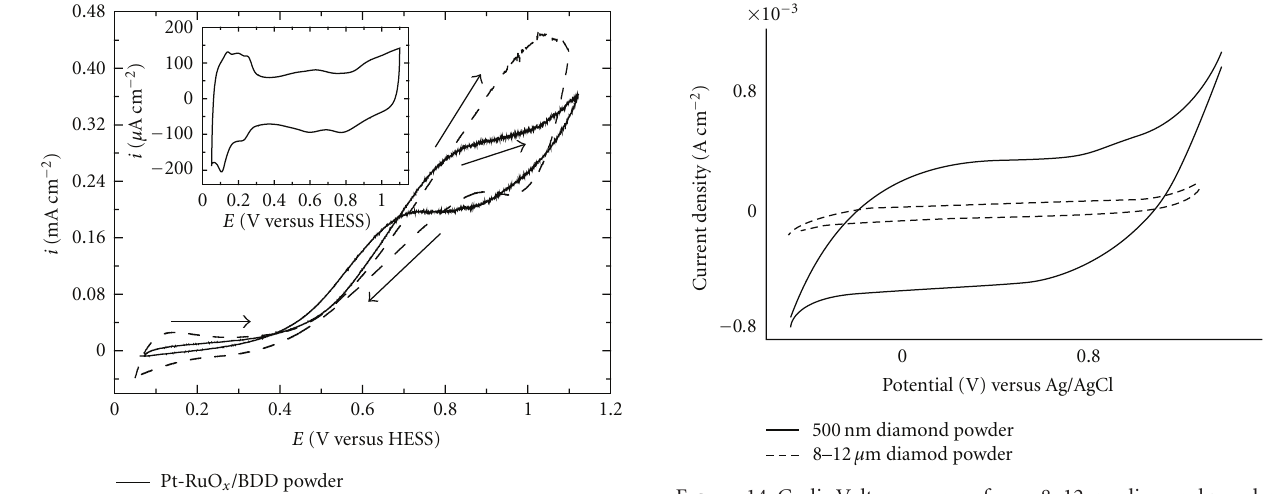
Figure 14: Cyclic Voltammogram for an 8–12 μ m diamond powder electrode, grown under microcrystalline conditions, and a 500 nm diamond powder electrode, grown under nanocrystalline conditions. Experiments were carried out in 1M KCl at 100 mVs − 1 (reprinted with permission from